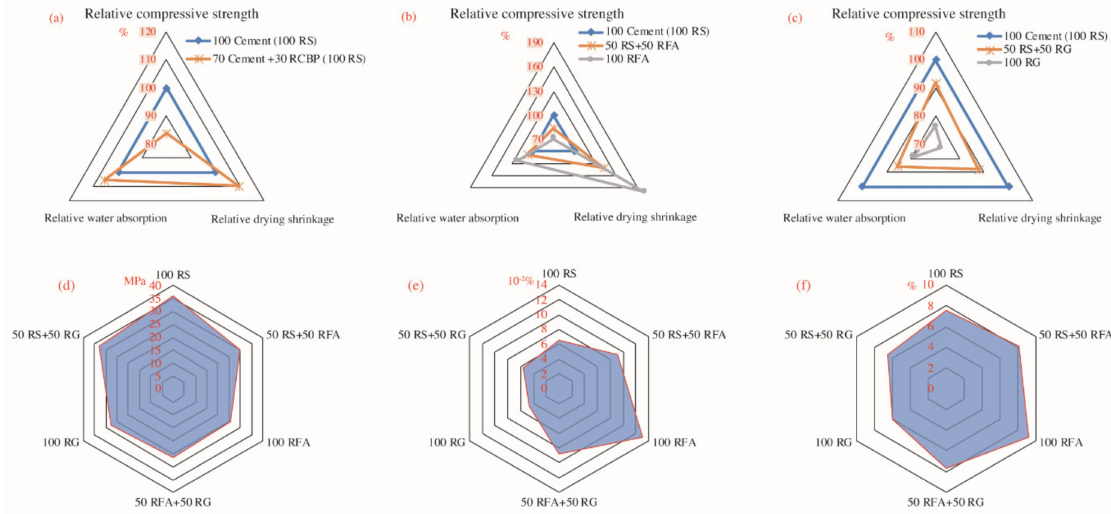
Figure 6. Hardened properties of photocatalytic mortar: ( a ) effect of RCBP on the mortar; ( b ) effect of RFA on the mortar; ( c ) effect of RG on the mortar; ( d ) effect of aggregate types on the compressive strength; ( e ) effect of aggregate types on the drying shrinkage; ( f ) effect of aggregate types on the water